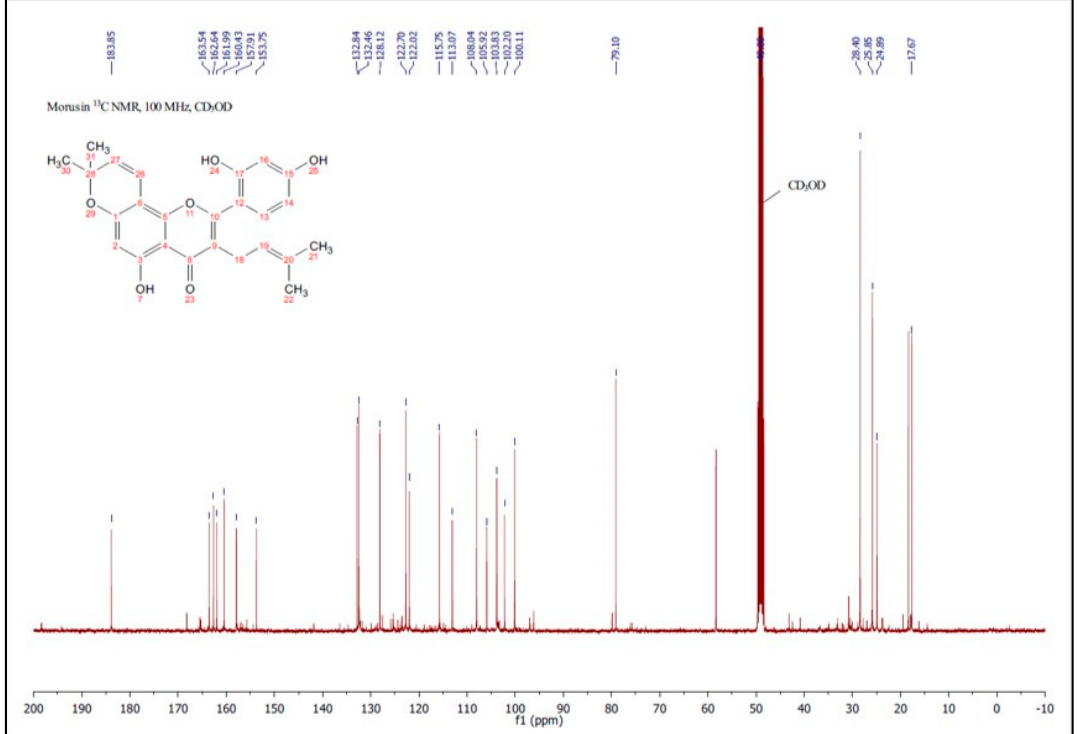
Figure A7. 13 C-NMR (100 MHz, CD 3 OD) spectrum of the compound Morusin.